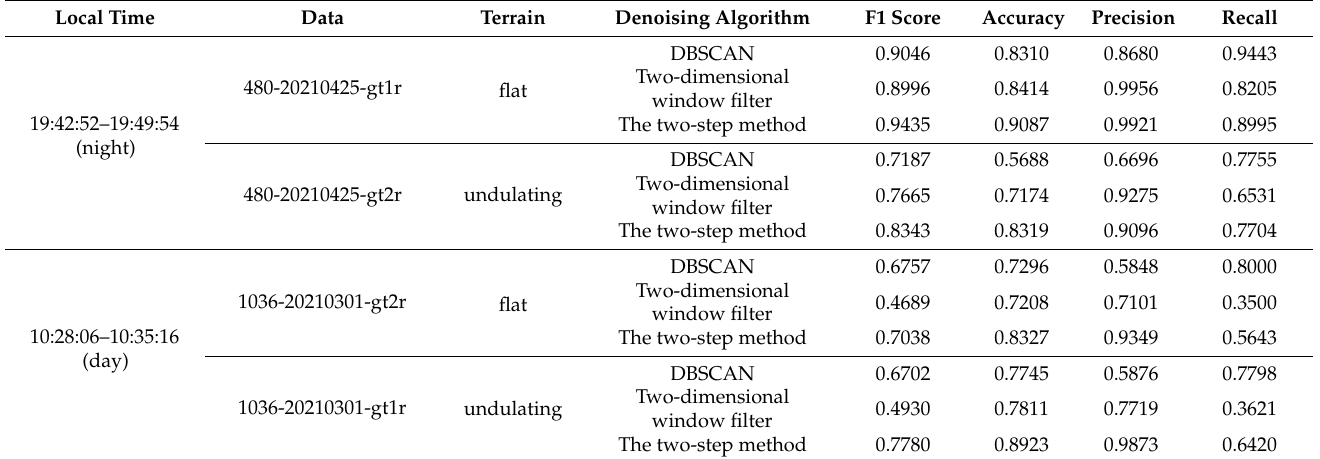
Table 2. Table of denoising accuracy of different methods in different time periods and different